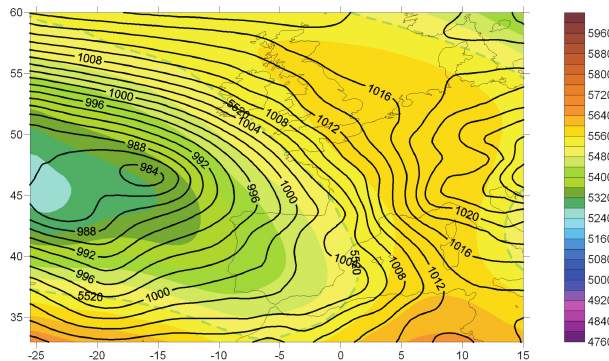
Fig. 10. SLP (lines) and Z500 (colours) during an SA situation. 22/12/2000 at 12:00UTC from ERA-Interim reanalysis done by Eu- ropean Centre for Medium Weather Forecast (ECMWF).